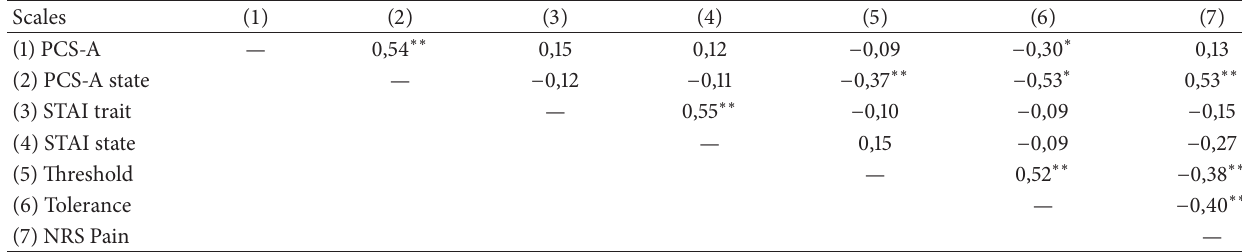
Table 5: Intercorrelations among study